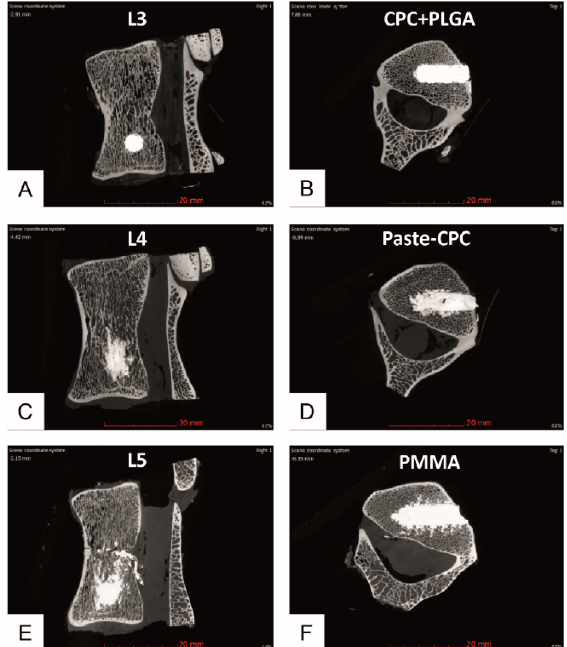
Figure 2. Representative micro-computed tomography (CT) pictures of vertebrae injected ex vivo with CPC + PLGA (( A )—sagittal; ( B )—transversal), Paste-CPC ( C , D ), or PMMA ( E , F ); micro-CT